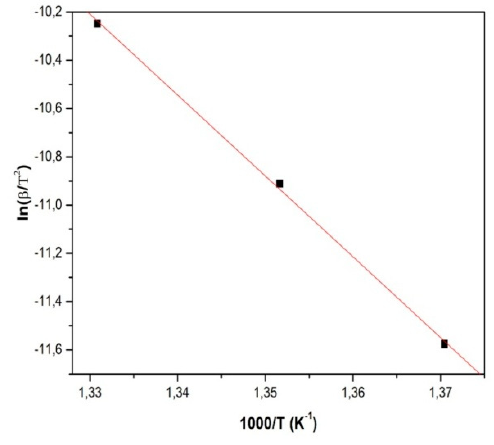
Figure 3. The Kissinger plot of Zr 55 Cu 30 Al 10 Ni 5 .